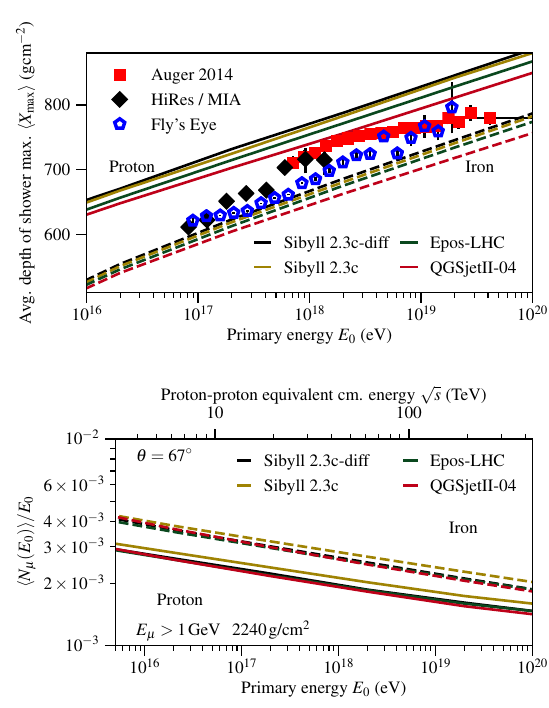
Figure 5. Model predictions of X max compared with data, in- cluding the tuned SIBYLL2.3c-di ff model (top). Comparison of muon number at ground level predicted by models, the muon number of tuned SIBYLL2.3c-di ff model decreased 8-10% com- pared to the original SIBYLL2.3c model η < 2.5 are | |